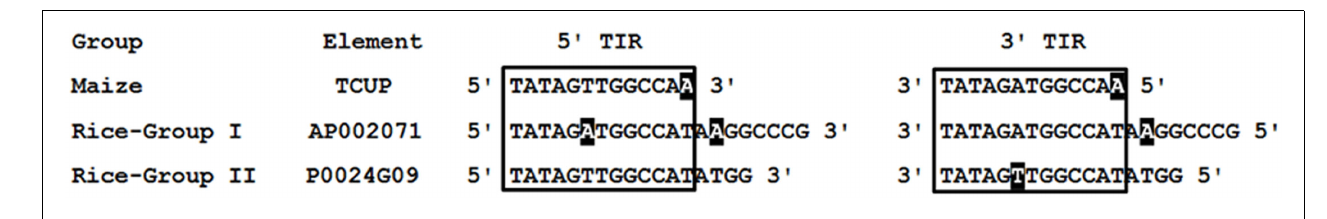
FIGURE 4 | Comparison of maize TCUP and rice TCUP -likeTIRs. Rice elements are grouped according to size.TIR sequences identical to the maize